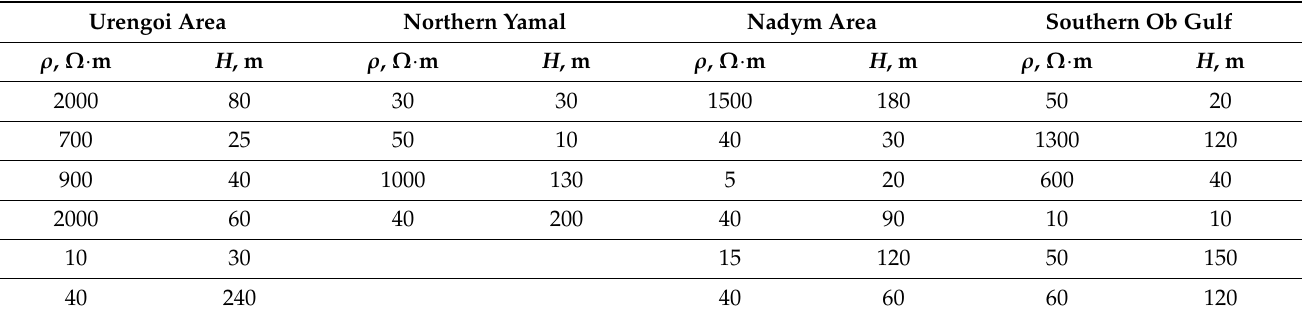
Table 1. sTEM resistivity